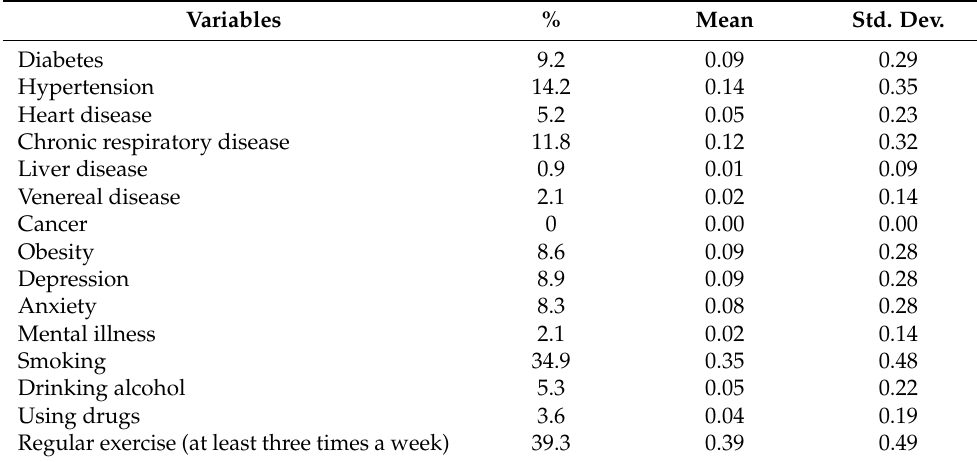
Table 3. Health and risk behaviors among the rural population (N =